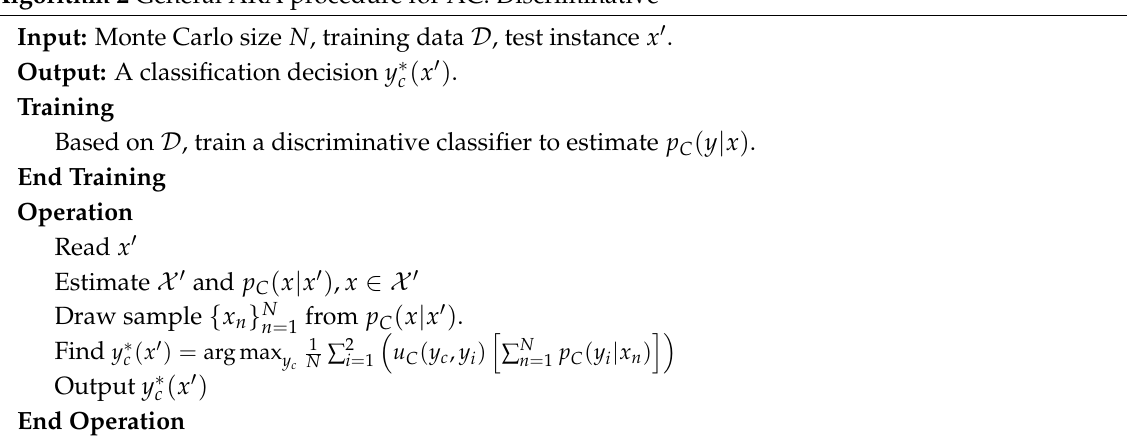
Algorithm 2 General ARA procedure for AC.